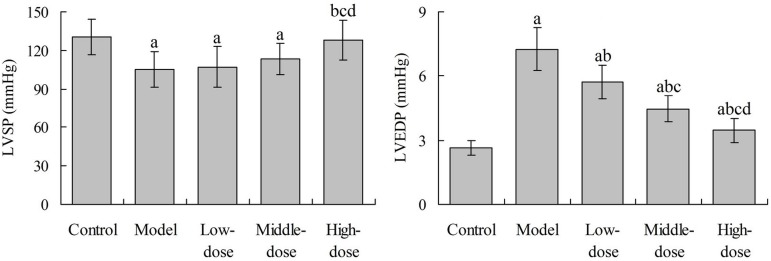
Effects of baicalin on hemodynamics of rats.aP<0.05 compared with the control group;
bP<0.05 compared with the model group;
cP<0.05 compared with the low-dose group;
dP<0.05 compared with the middle-dose group.LVSP=left ventricular systolic pressure; LVEDP=left ventricular end
diastolic pressure